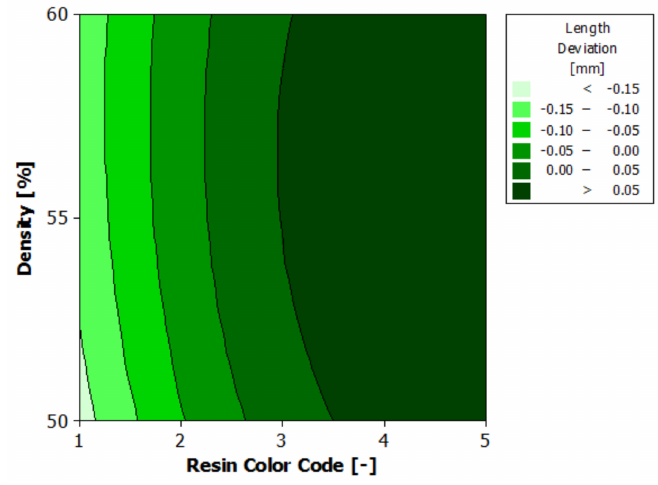
Figure 9. Contours of estimated response surface for length deviation.